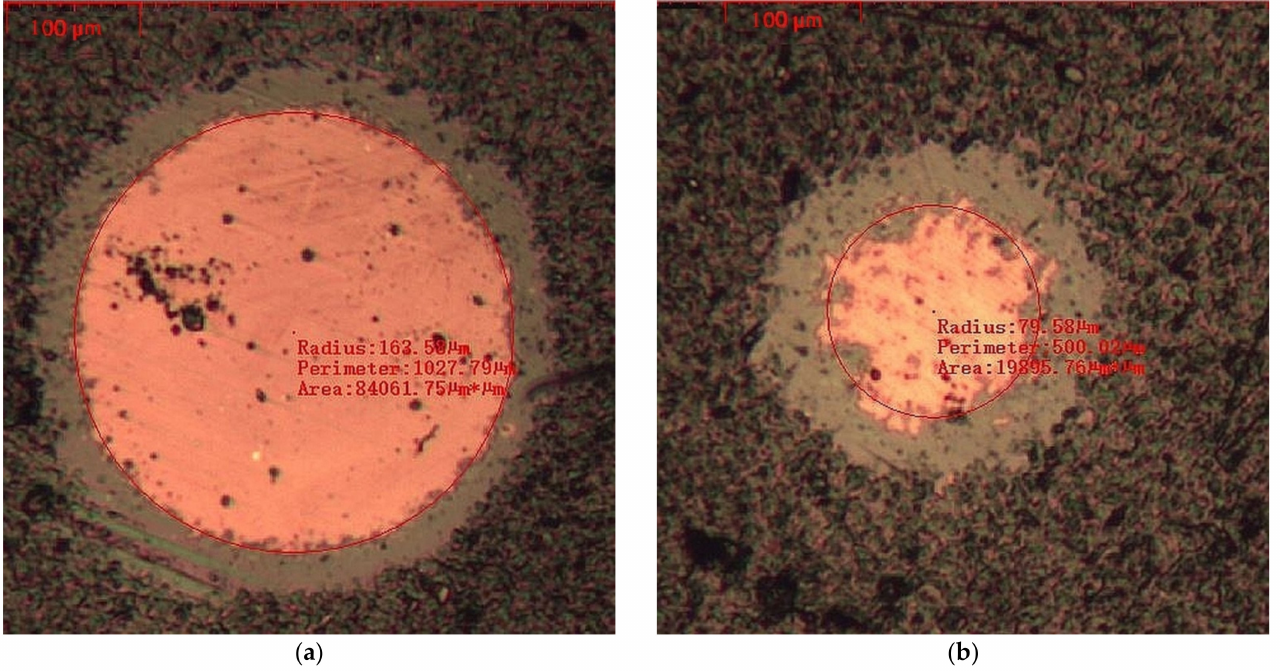
Figure 9. The wear crater of ( a ) N-H-PVD and ( b ) N-H-PN-PVD test